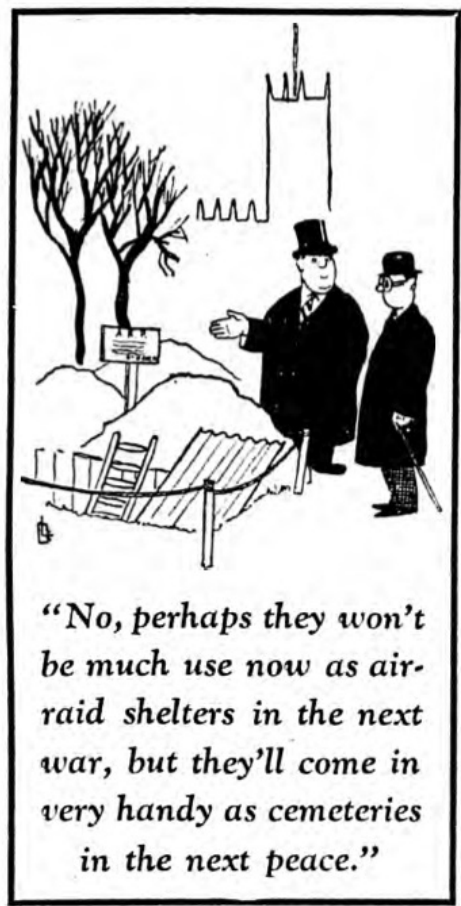
Cartoon by Osbert Lancaster, Daily Express (6 January 1939),